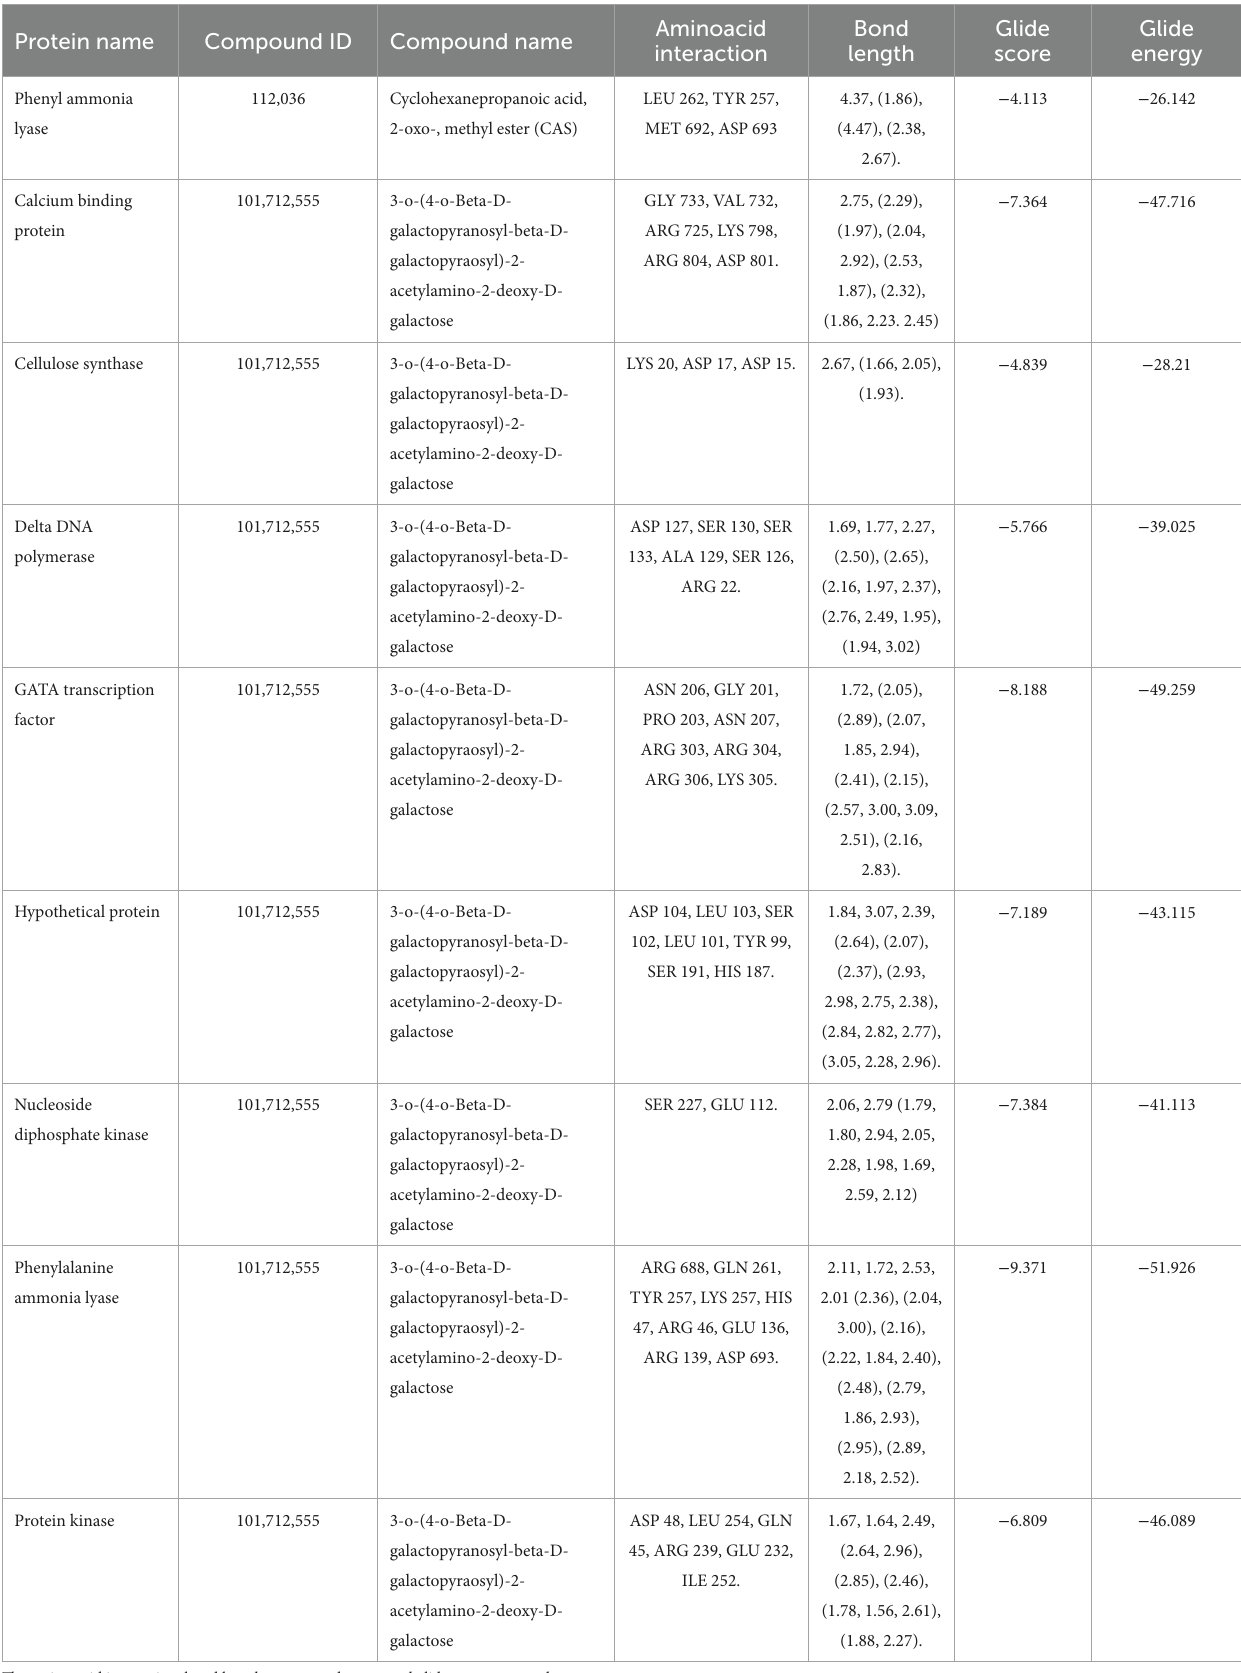
TABLE 5 The molecular docking experiment was carried out for the differently expressed proteins with secondary